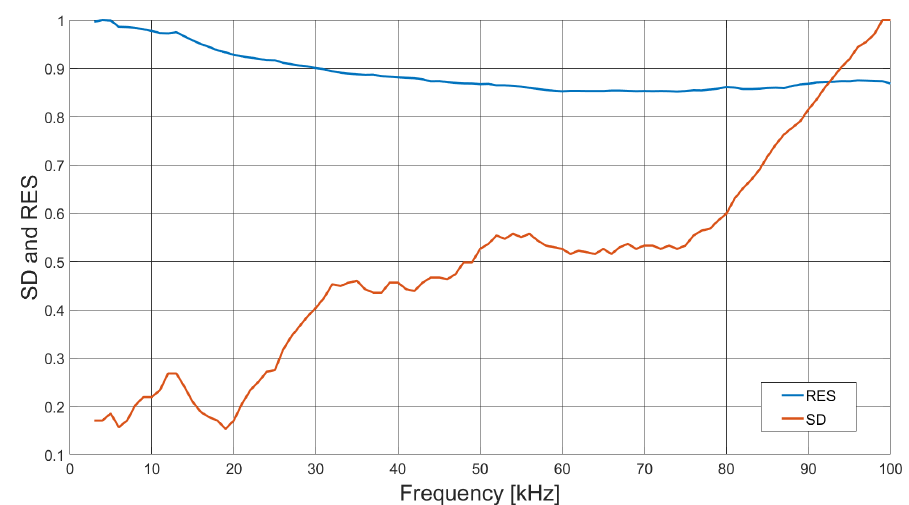
Figure 14. Reconstructed image resolution (RES) and shape deformation (SD) of internal object measurement using a conducting shroud, where shroud frame data are subtracted ( ∆ V = V both − V shrd ). Using a threshold value of k th = 0.3 in Equations (13)–(15), frame data were collected over a frequency range of 2 to 100